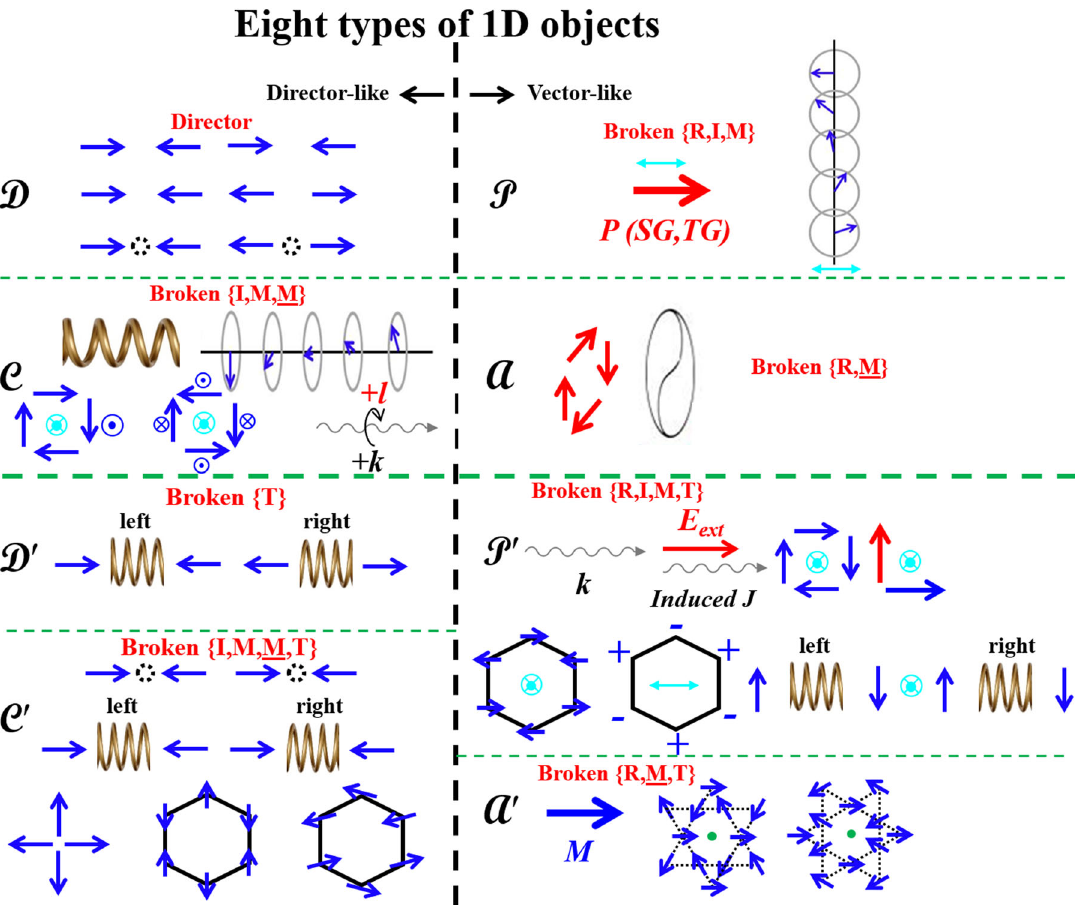
Fig. 1 Eight types of 1D objects. Each type has a particular set of broken symmetries: D ; no broken symmetry, C ; broken { I , M , M }, D 0 ; broken a a 0 ; broken { R , M , T }. When { T } is additionally broken, { T }, C 0 ; broken { I , M , M , T }, P ; broken { R , I , M }, ; broken { R , M }, P 0 ; broken { R , I , M , T }, a a 0 , respectively. Note that all left-hand-side 1D objects ( D ; C ; D 0 ; C 0 ) have not-broken { R }, so then D , C , P , and become D 0 ; C 0 ; P 0 ; they are director-like, and all right-hand-side 1D objects ( P ; R ; P 0 ; R 0 ) have broken { R }, so they are vector-like. A large number of quasi-1D schematic examples are also shown: blue arrows are spins or magnetization, red arrows are polarizations or electric fi elds, wiggly arrows are velocity vectors or linear momenta, “ + l ” represents angular momentum or circular polarization, light-blue symbols depict the reference 1D direction, green dots are inversion centers, dashed black circles are anions, and golden springs represent mono-axial chiral objects. The reference 1D direction is the horizontal direction on the page plane, except when there is an explicit light-blue symbol depicting the 1D orbital angular momentum along the linear momentum direction, circularly-polarized light, and vortex beam having orbital angular momentum along the vortex beam direction. For example, the point groups 222, 32, 422, 622, and 23 fi t the criteria of broken { I , M , M }. P (broken { R , I , M }): polarization ( P ). Strain gradient, thermal gradient, and cycloidal spins. For example, the point groups 2mm, 3m, 4mm, and 6mm fi t the criteria of broken { R , I , M }. a (broken { R , M }): axial vector of ferro-rotation. Crystal- lographic rotational distortions, and electric toroidal moment. For example, the point groups 1 ; 3 ; 4 ; 6, 2/m, 4/m, and 6/m fi t the